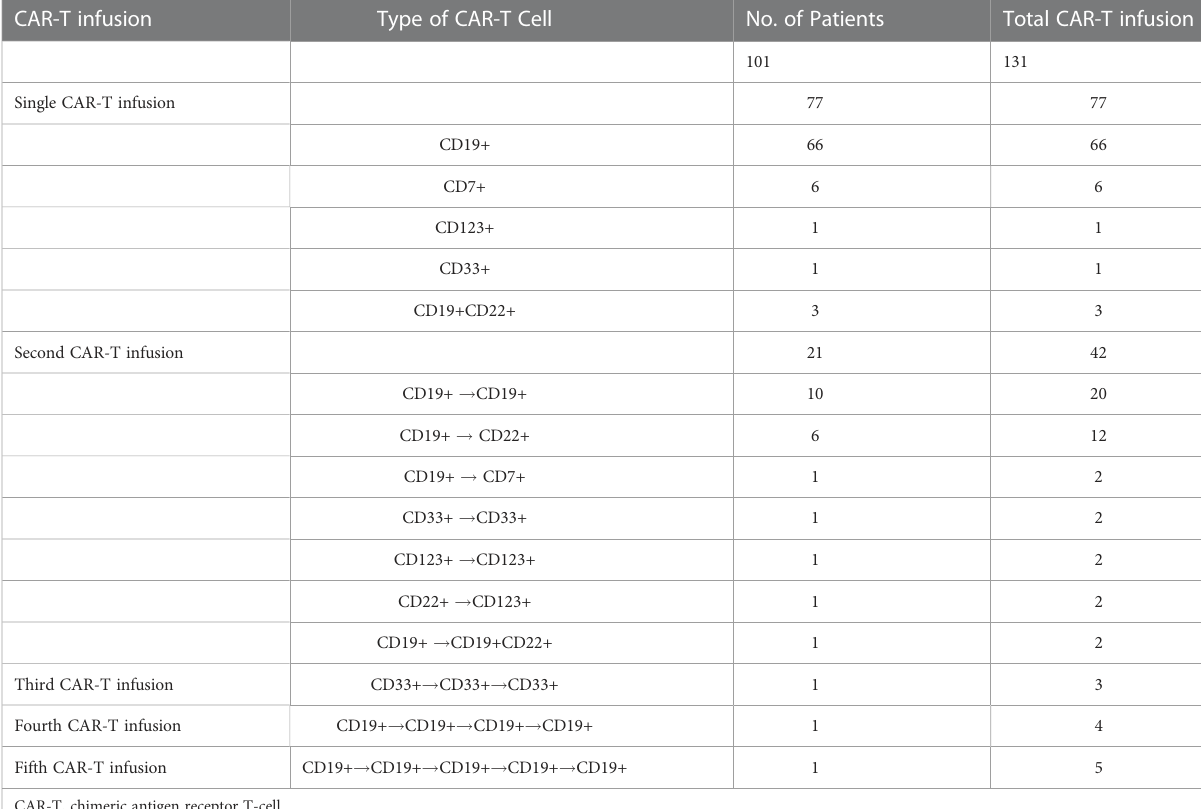
CAR-T, chimeric antigen receptor T-cell. “ → ” means “ changed to ”